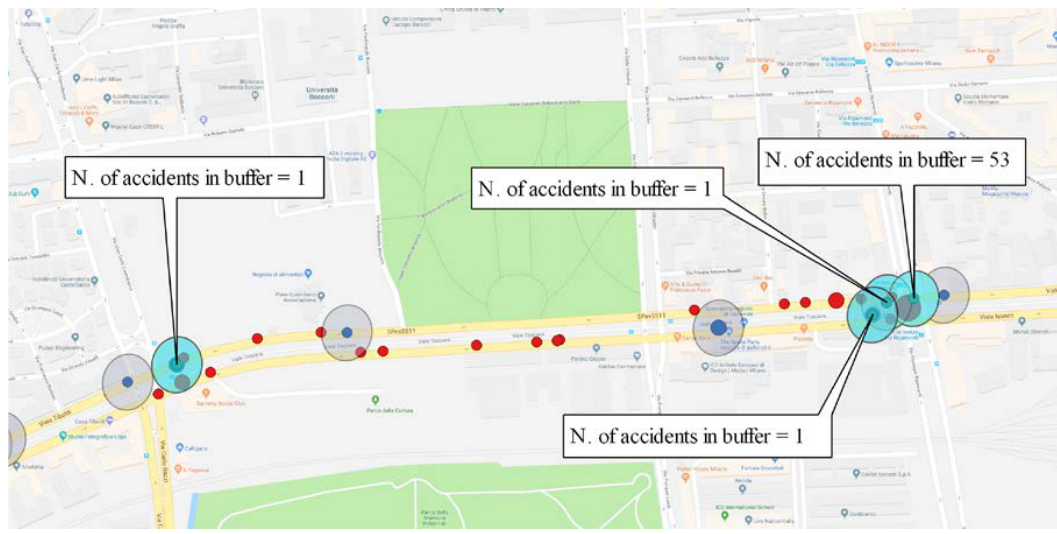
Figure 12. Example of a route—accidents identified in red, and stress points in blue. Circles indicate the buffer around stress points (QGIS elaboration of Google Maps).